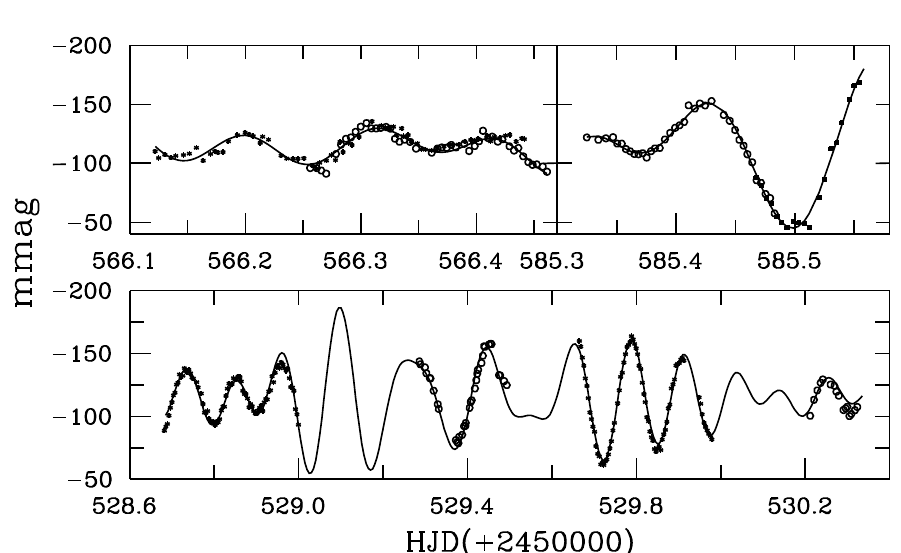
Fig. 4. Differential three-star photometry in the V passband of δ Scuti type star 4 CVn during the multi-site campaign of March-May 1997 (Stankov et al. 2000). Top panel: open circles – data from Mt. Dushak- Erekdag; open stars – data from Tien-Shan; filled circles – data from Abas- tumani, Georgia. Bottom panel: open circles – data from Mt. Dushak- Erekdag; asterisks - data from Vienna APT (Arizona). The fit, taken from Breger et al. (1999), is shown by a solid